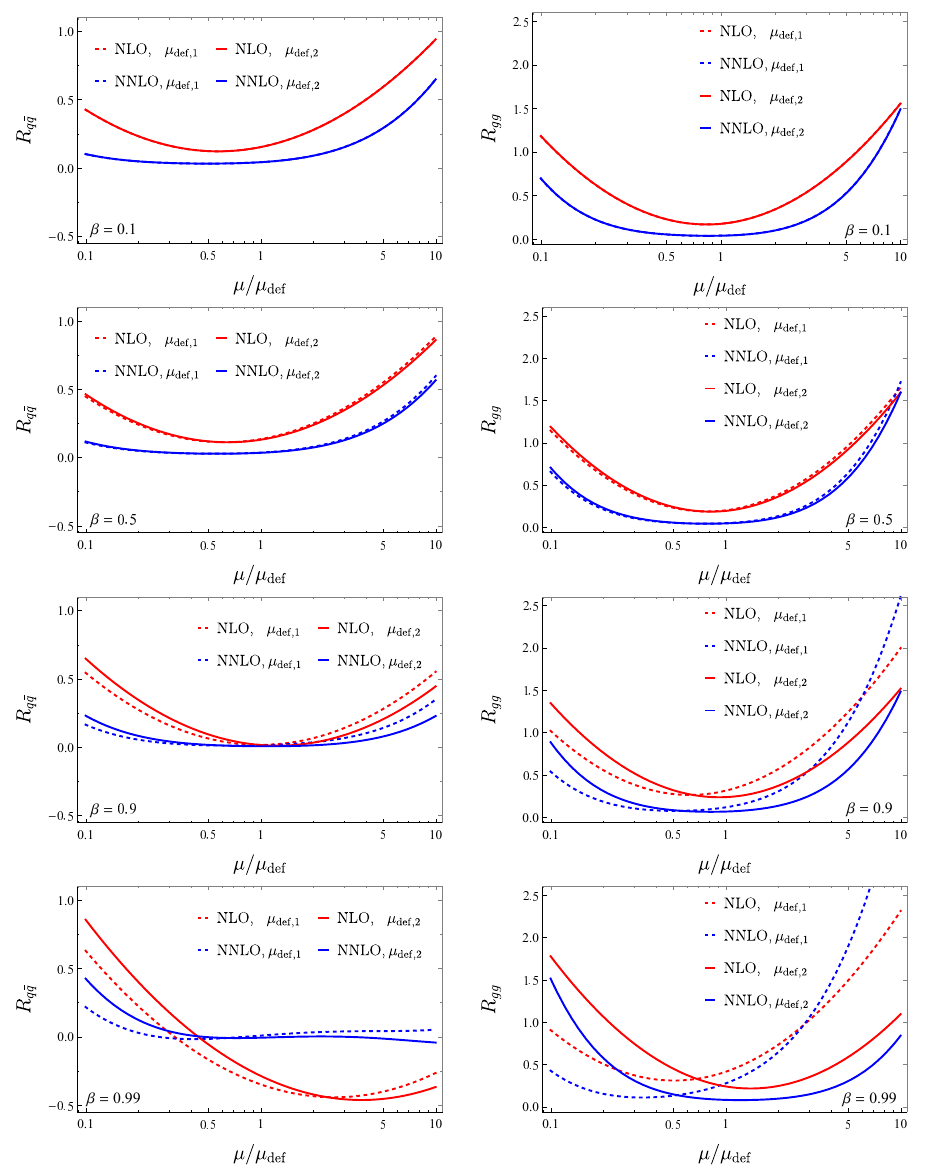
Figure 9 . Relative soft corrections as a function of µ/µ def for two choices of the default scale: µ def , 1 = Λ (dashed curves) and µ def , 2 = Λ